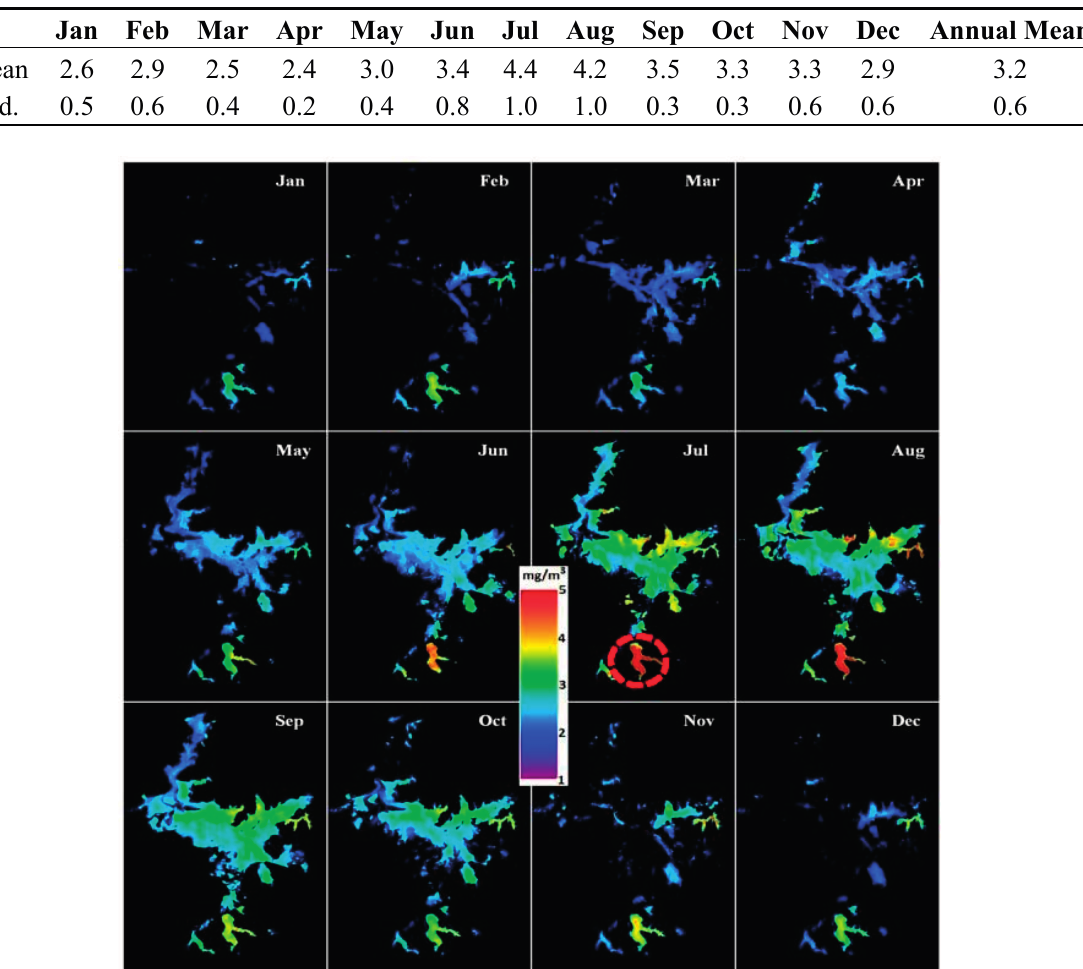
Table 2. Chl-a mean of Poyang Lake during each climatological month derived from MERIS measurements between 2003 and 2011. Also listed in the last column is the annual mean and annual standard deviation. Note that the Std. values in the third line are the standard deviations of nine monthly mean Chl-a from 2003 to 2011.